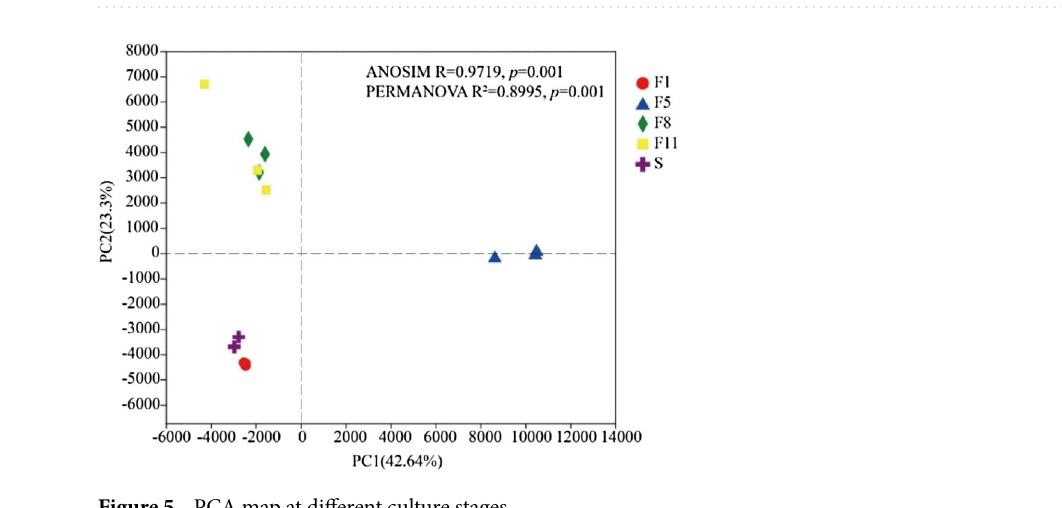
Figure 5. PCA map at different culture